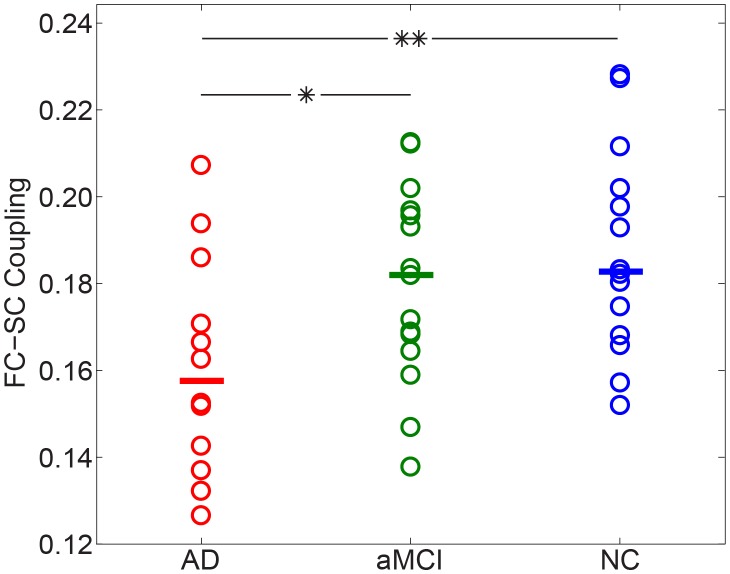
The functional connectivity (FC) – structural connectivity (SC) coupling for AD patients, aMCI patients, and healthy controls.AD patients exhibited a significant decrease in FC-SC coupling compared to aMCI patients and healthy controls. Significant statistical differences are indicated with * for p<0.05 and ** for p<0.01.